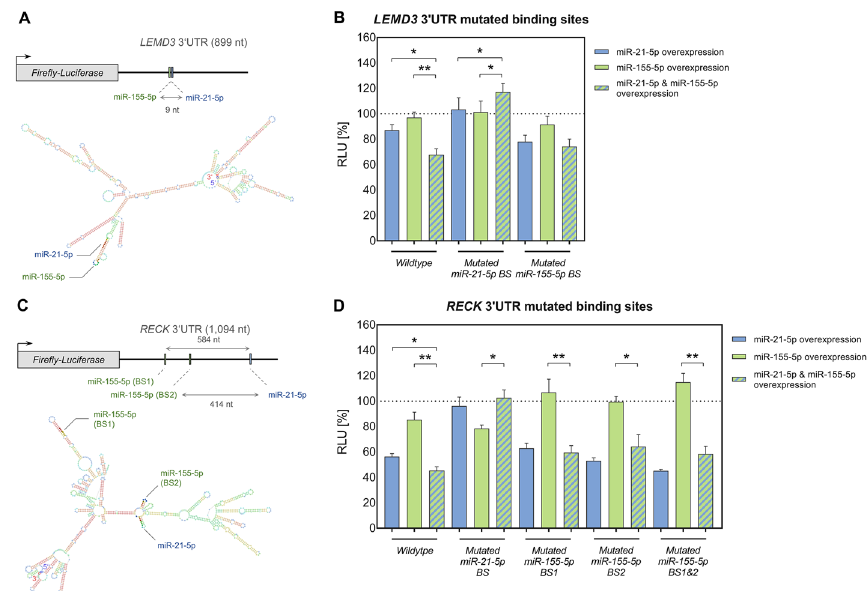
Fig. 3 In silico prediction of 3’UTR secondary structures and exemplary validation miRNA cooperative effects. A , C : RNA secondary structures were predicted for LEMD3 ( A ) and RECK ( C ) 3 ′ UTR sequences that showed cooperative binding of miR‑21‑5p and miR‑155‑5p as determined by the HiTmIR dual luciferase assays. Corresponding 3 ′ UTR sequences (as cloned for the underlying assays) are shown in a linearized (upper panel; 5 ′ 3 ′ ) and in a folded representation (lower panel), respectively. The included miRNA binding sites → are indicated. B , D For the validation of miRNA cooperative effects, miR‑21‑5p and miR‑155‑5p binding sites were mutated within pMIR‑ LEMD3 ( B ) and pMIR‑ RECK ( D ) 3 ′ UTRs. The reporter constructs were tested by HiTmIR dual luciferase reporter assays. Comparative measurements were conducted with both, the wild type and mutated reporter constructs. MiRNA induced effects were determined upon overexpression of only miR‑21‑5p or only miR‑155‑5p or upon co‑expression of both miRNAs. Relative luciferase units (RLU) were related to the activity of an empty reporter control (pMIR‑RNL‑TK; under the respective miRNA condition) and are shown as the mean result ( standard error of the mean ( SEM)) of three independent experiments ± ± that were conducted in technical duplicates. Statistical evaluation of the cooperative effects was performed in comparison to the effects upon single miRNA overexpression of miR‑21‑5p or miR‑155‑5p (black asterisks). Significant p‑values after FDR adjustment are denoted (*p 0.05, **p < 0.01, ***p < ≤